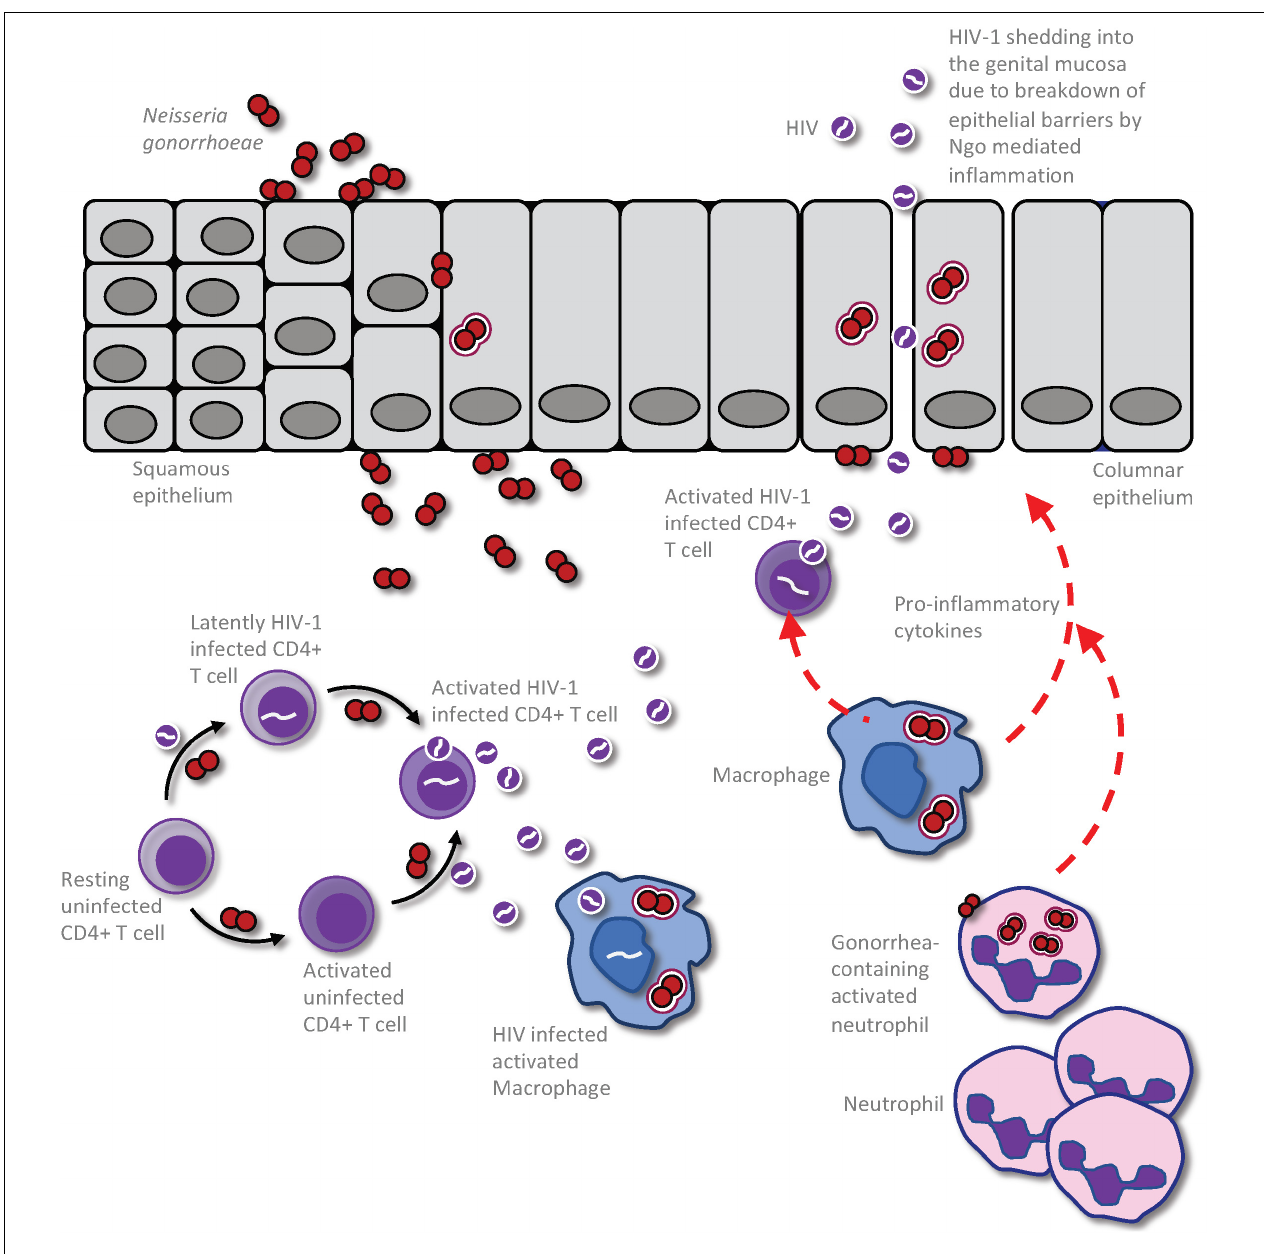
FIGURE 1 | Impact of Neisseria gonorrhoeae infection on HIV production and shedding in an already HIV infected person. The presence of the gonococci within the urogenital tract results in an exuberant neutrophil response that is characterized by increased presence of pro-inflammatory cytokines and chemokines. This results in the recruitment of infected CD4 T-cells to the area of gonococcal infection, leading to activation of the latent HIV and release of virions to the genital microenvironment. This event could also result in infection of HIV-uninfected but gonococcal-activated CD4 T-cells and further propagation of the virus within the patient. Macrophage and dendritic cells (DCs) may also take up the virus to be presented to CD4 T-cells in distal lymphoid organs, increasing the efficiency of CD4 T cell infection and causing further propagation of infection, ultimately leading to destruction of secondary lymphoid organs. Following gonococcus-induced disruption of the epithelial barrier, either directly by the bacterium or through the inflammatory milieu, the cell free HIV particles may be released freely into the genital lumen to increase infectious potential of this HIV infected individual.